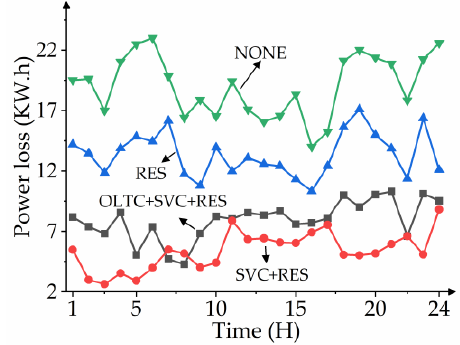
Figure 5. The daily load fluctuation ratios of the bus 14 and bus 26 in case 1 ( a ) and case 4 at scene 3 ( b ).